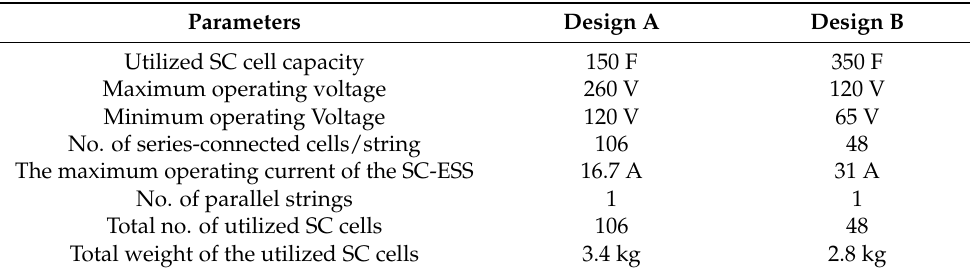
Table 2. Comparing Design Options for